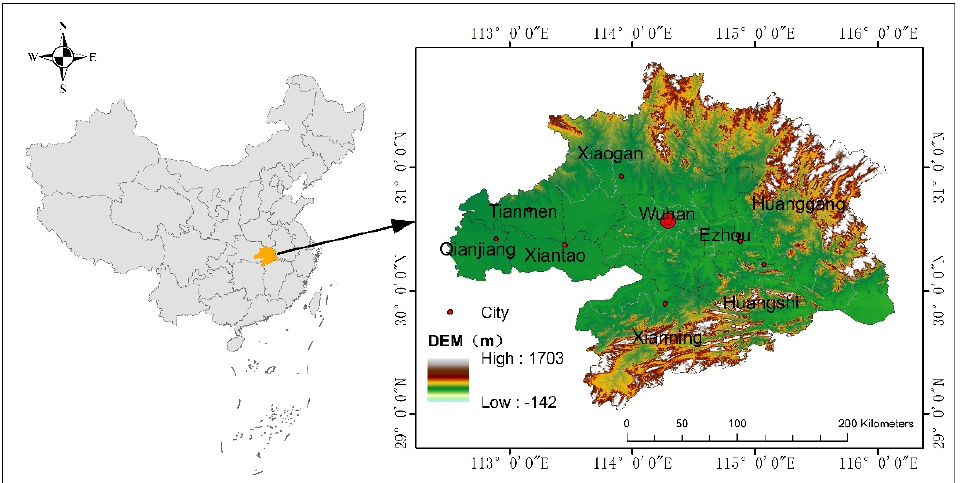
Figure 3. Spatial location of the Wuhan urban agglomeration.